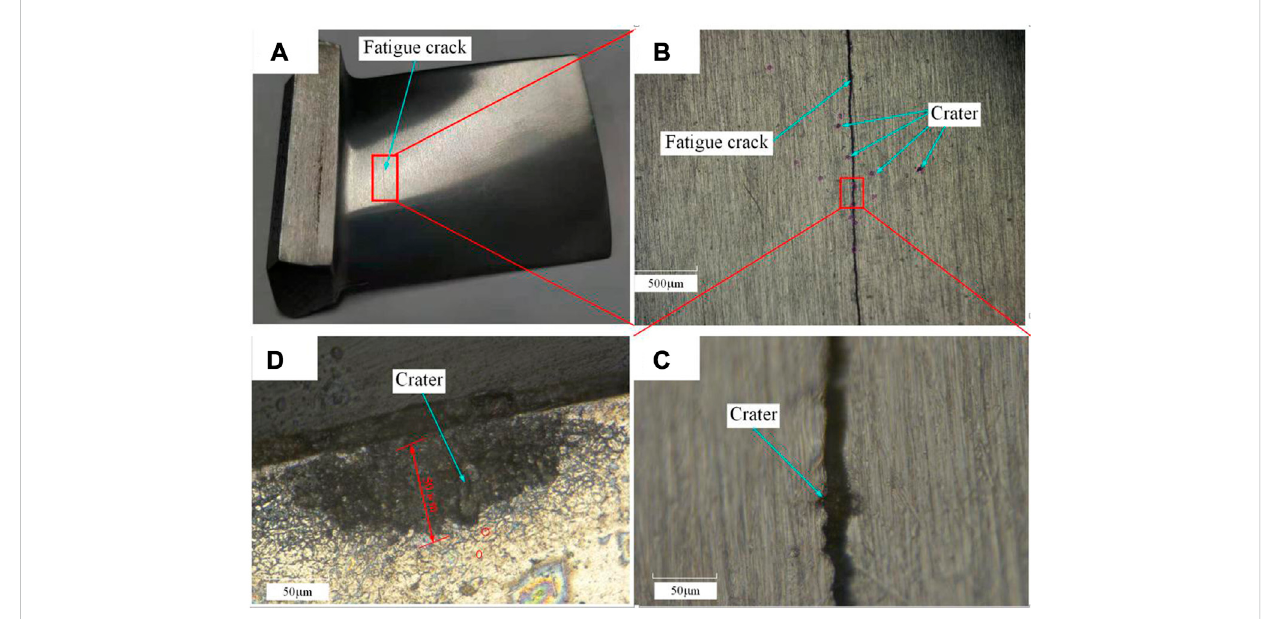
FIGURE 3 Surfacemorphologyofthefatigueblade. (A) Macro-cracksonthesurfaceoftheblade, (B) surfacemorphologynearthecracksource, (C) dimpleson the crack, and (D) cross-sectional view of the